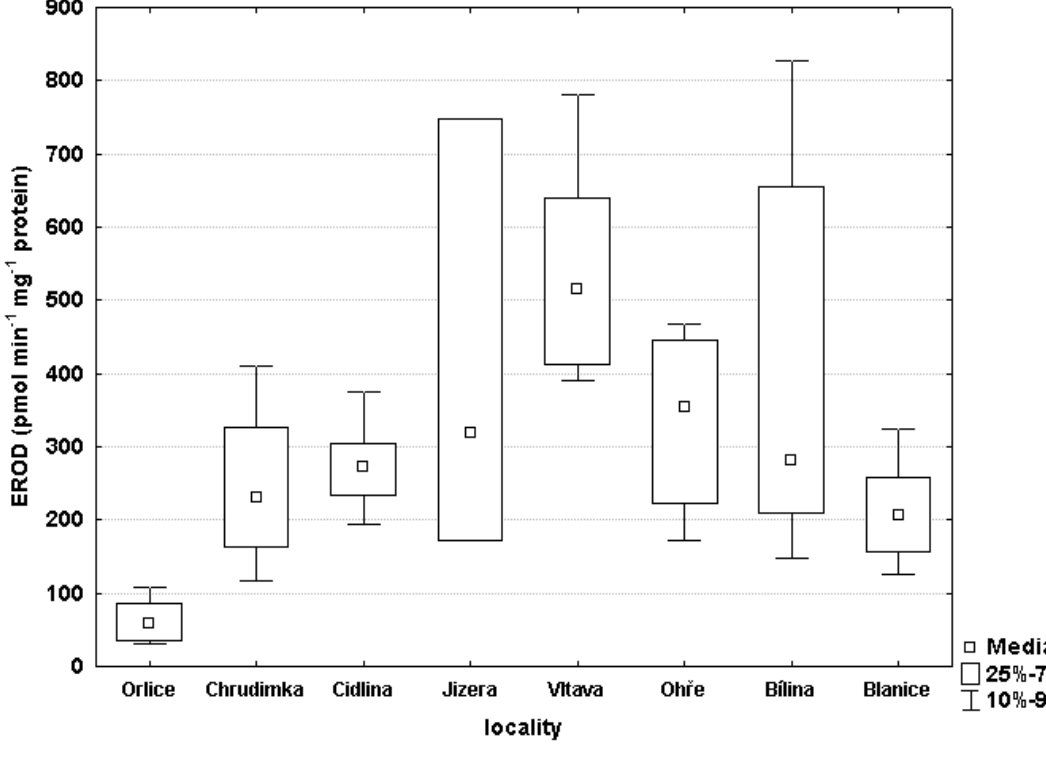
Figure 2. EROD activity in liver samples of male chub